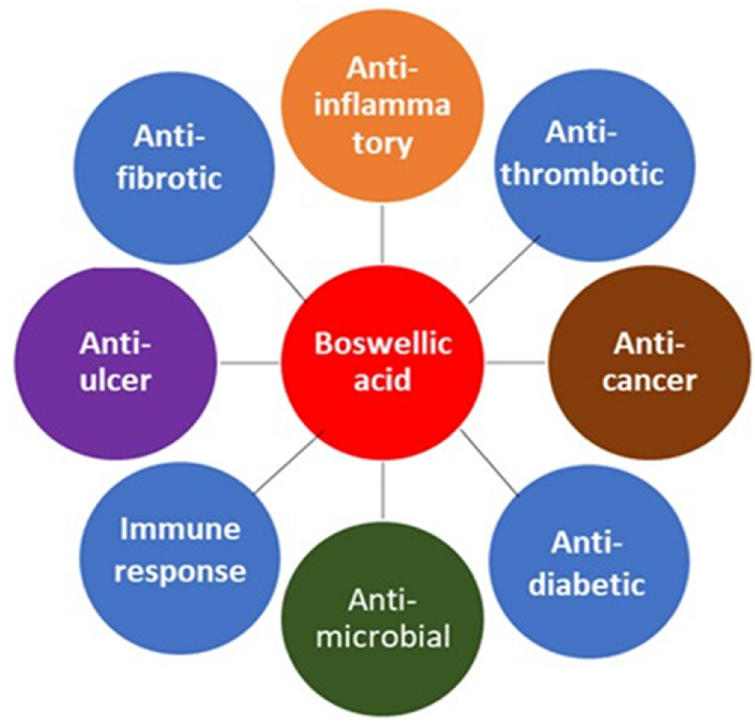
Figure 3. Modern medicinal uses of Boswellia .